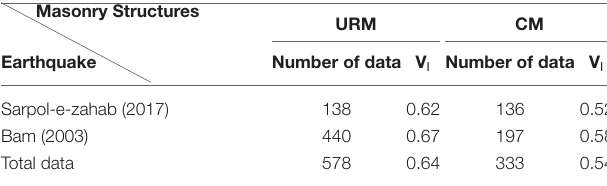
TABLE 4 | Vulnerability indexes for Iranian masonry buildings.